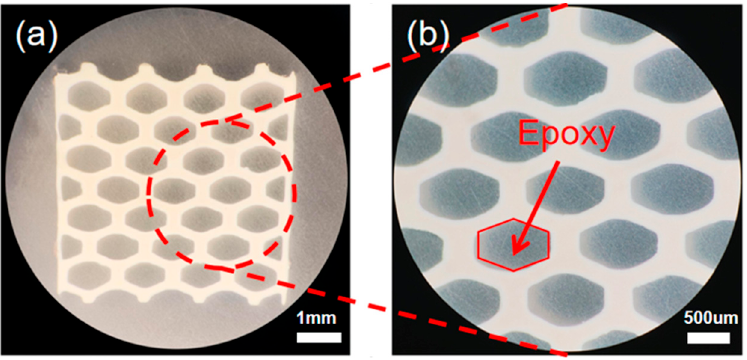
Figure 5. ( a ) Sintered sample filled with epoxy resin under a microscope with a scale bar of 1 mm. ( b ) Detail of the sample under the microscope with a scale bar of 500 µm.